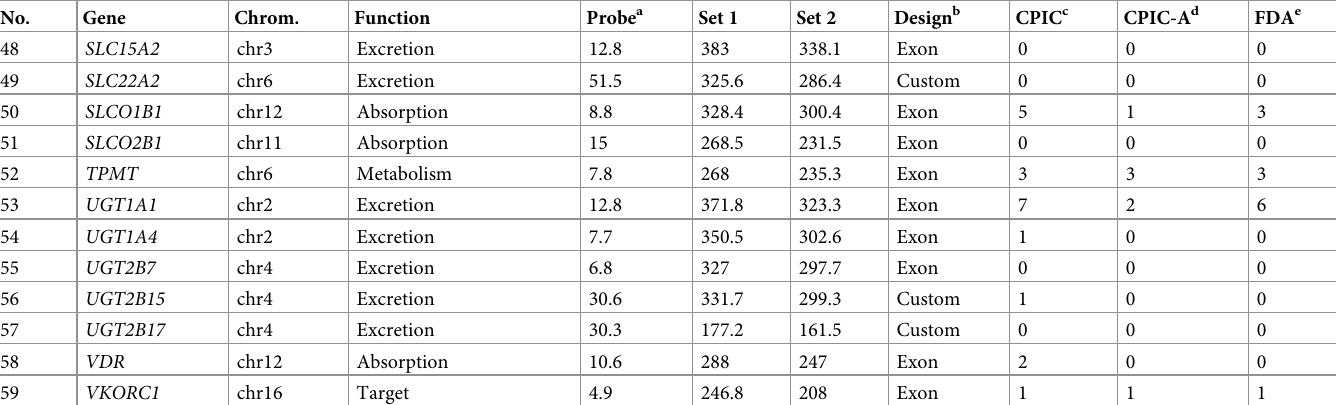
Abbreviations: No., number; Chrom., chromosome; CPIC, Clinical Pharmacogenetics Implementation Consortium; FDA, Food and Drug Administration. Samples were sequenced in two separate runs (N = 32 for Set 1 and N = 32 for Set 2). a Total length of targeted regions in kilo base pairs. b Panel design strategy used to probe each gene. The ‘exon’ design includes probes for targeting exons and upstream/downstream regions of a gene. The ‘custom’ design was used to capture genes with structural variation and/or complex polymorphism.